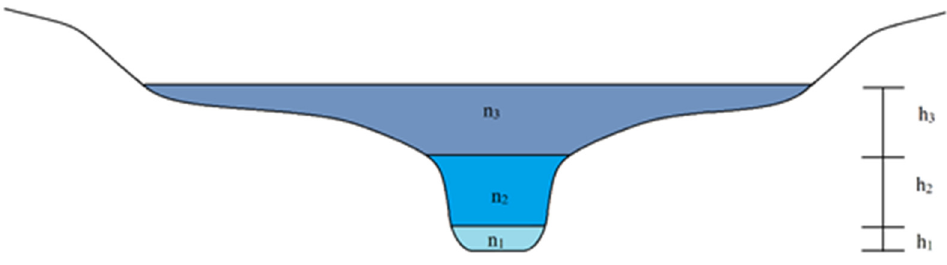
Figure 2. Representation of n along the cross-section.